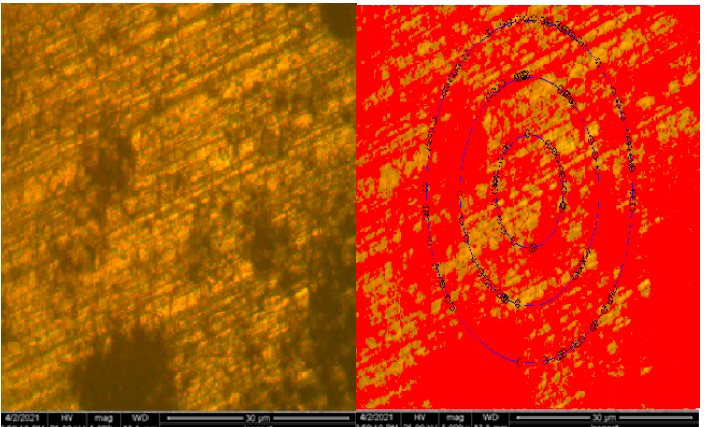
Figure 7. Microscopic appearance of austenitic grains for the forged semi-finished product 25CrMo4 [1].